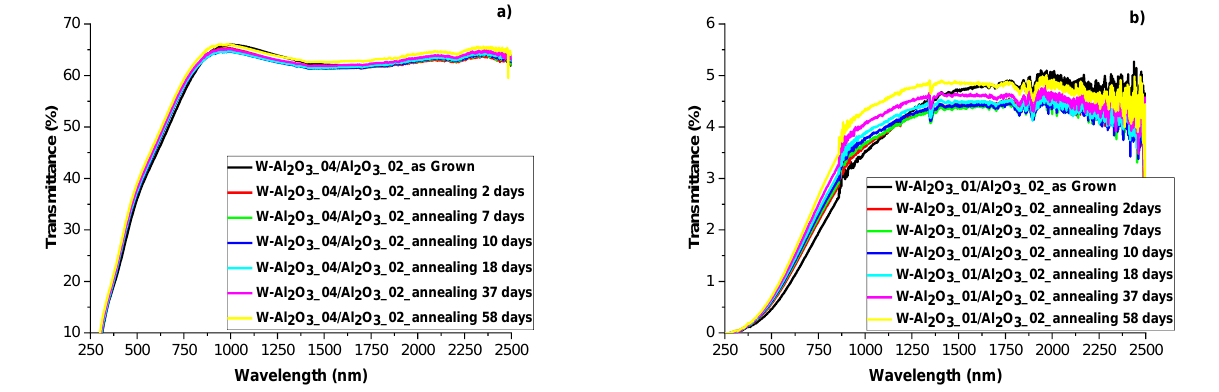
Figure 13. Comparison between the transmittance curves of as-grown and annealed samples: ( a ) Bilayer_01, ( b ) Bilayer_02.